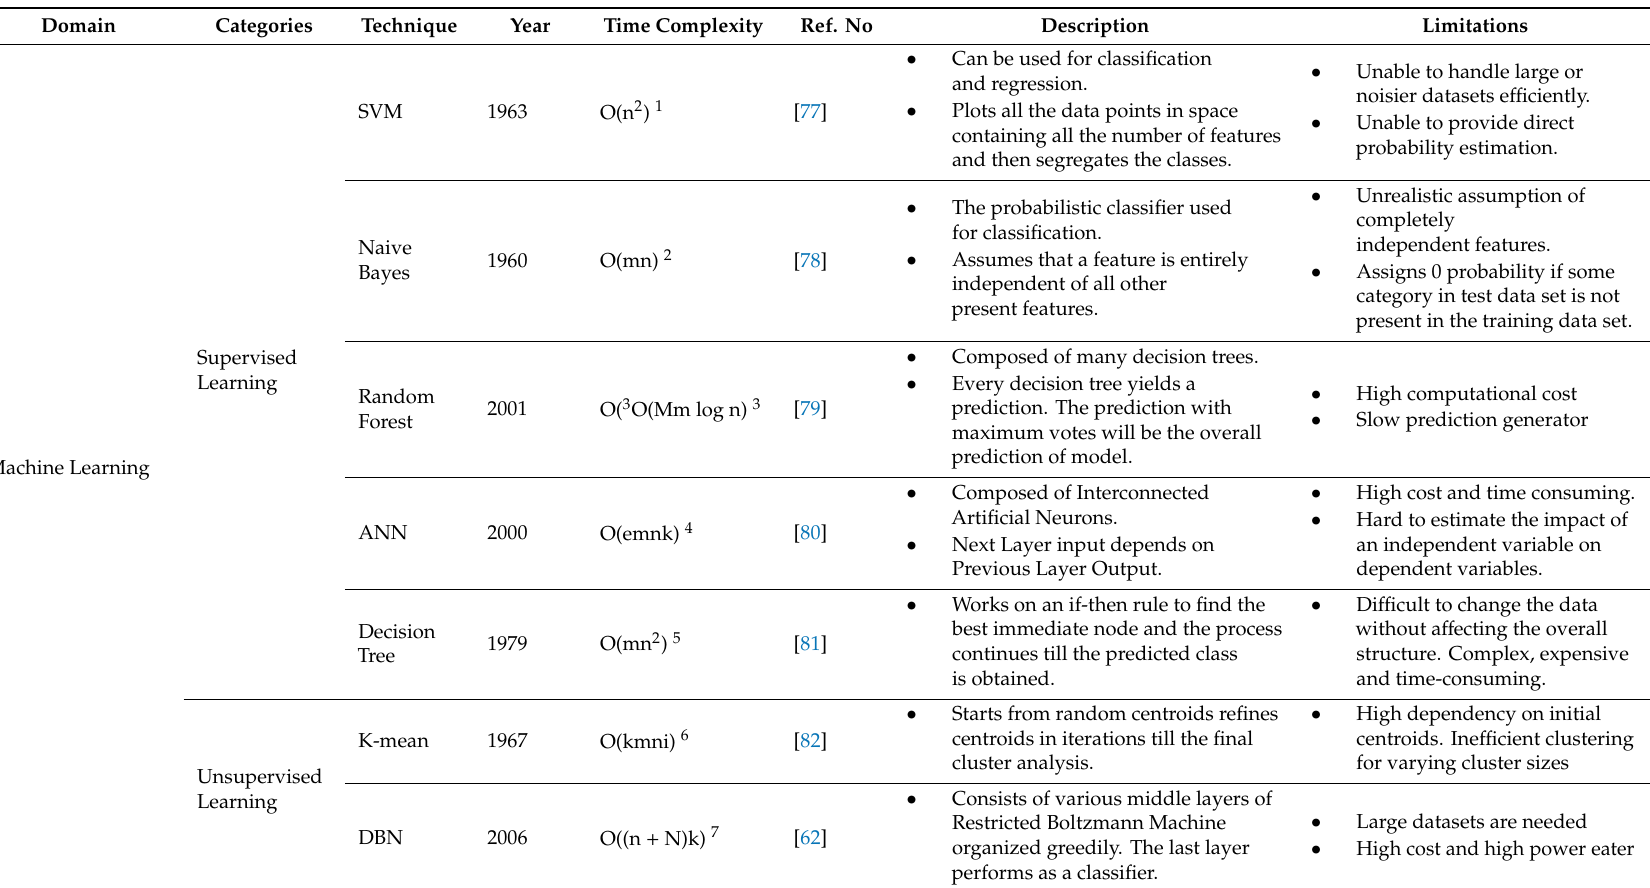
Table 2. Summary of Significant ML Techniques in